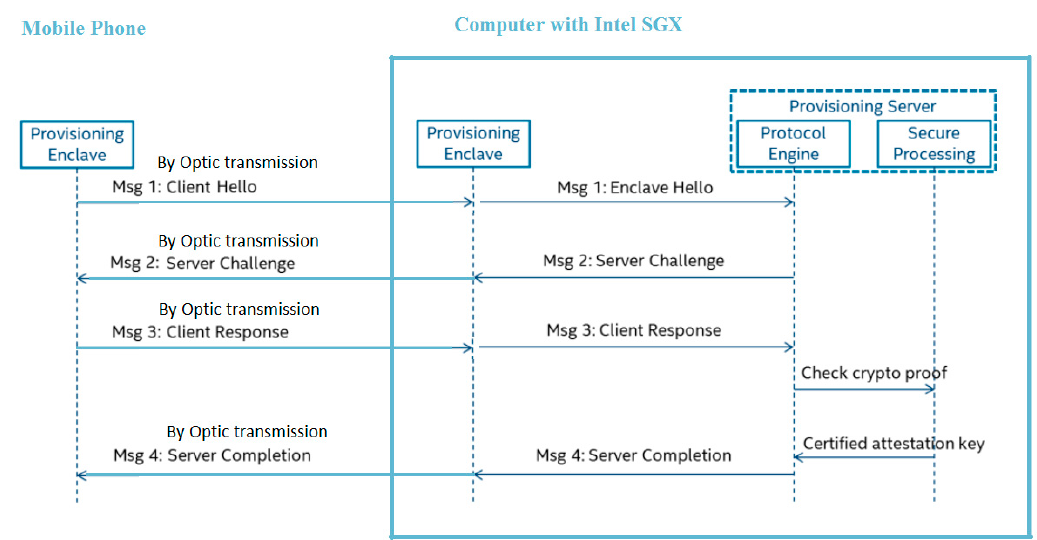
Figure 7. Optical-based provisioning message flow protocol.